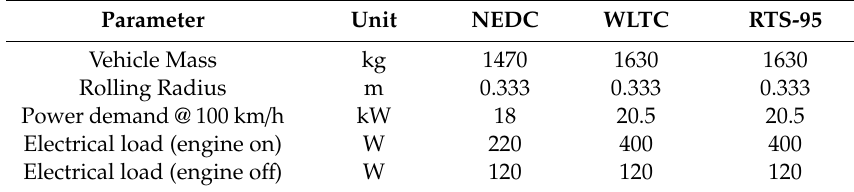
Table 1. Main vehicle characteristics for the New European Driving Cycle (NEDC), Worldwide Harmonized Light-Duty Vehicles Test Cycle (WLTC) and the standardized random test for an aggressive driving style